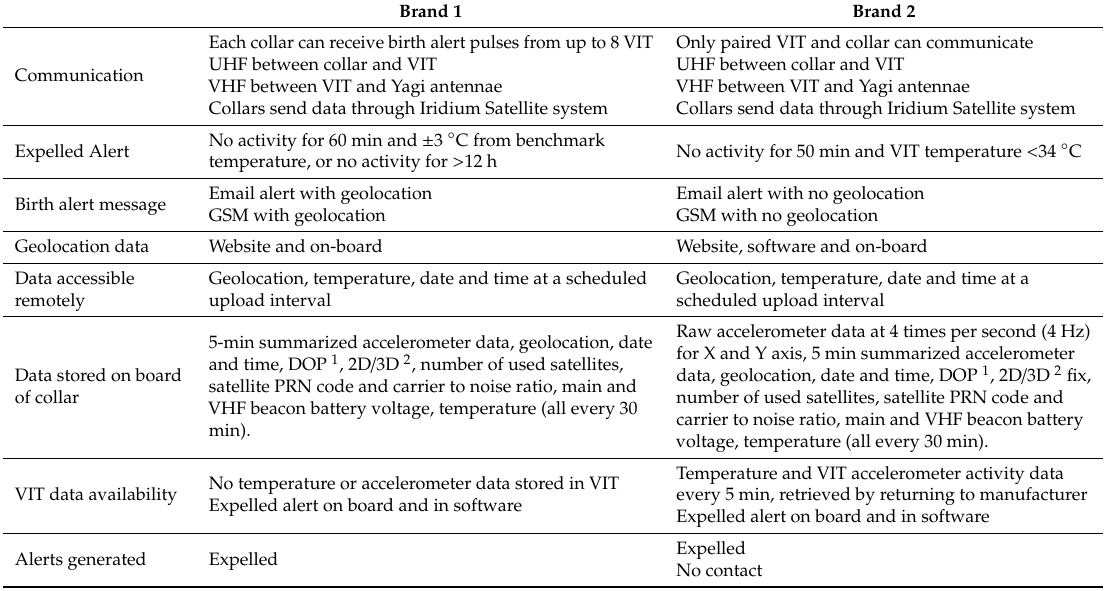
Table 1. Comparison of the two birth alert systems from vaginal implant tags (VIT) used in pregnant cows in the extensive beef cattle systems of northern